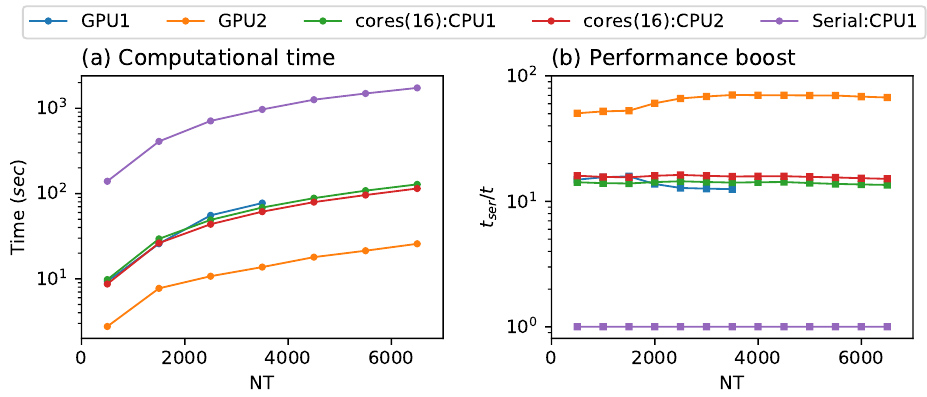
Figure 21. Comparison of computational time for 20 iterations and performance for variation of temporal grid size NT keeping spatial grid size constant ( NX = 201, NZ = 401) in FWI simulations.